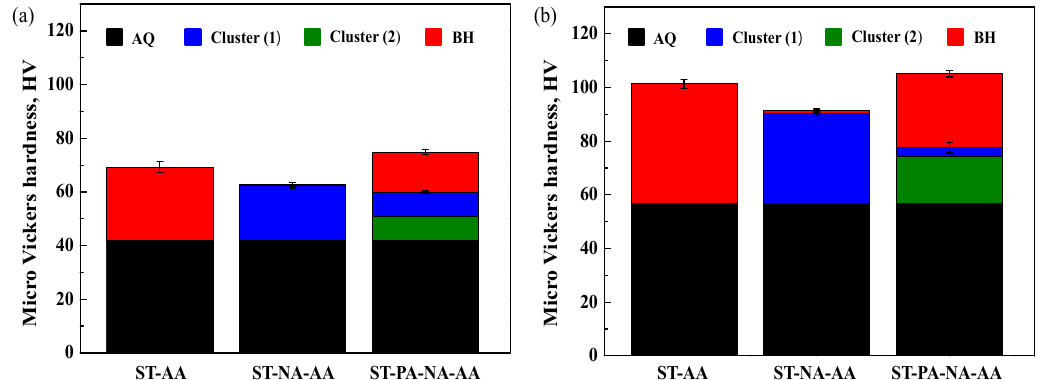
Figure 5. Hardness changes with each step of heat treatment in the ( a ) 3M10S and ( b ) 9M10S. AQ, ST, PA, NA, AA and BH stand for as-quenched, solid solution heat-treated, pre-aged at 100 ◦ C for 3600 s, naturally aged for 7 days, artificially aged at 170 ◦ C for 1200 s, and bake hardening response,